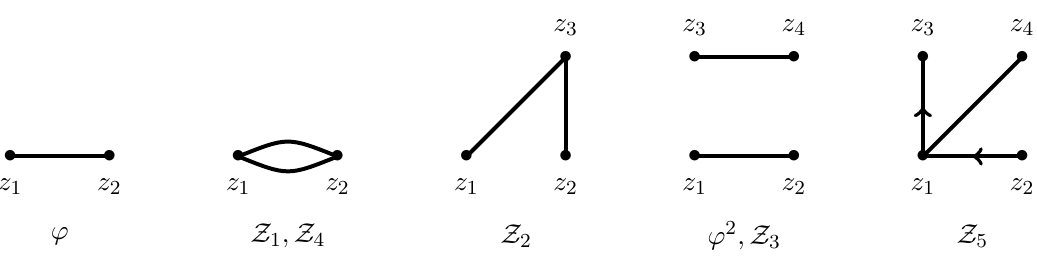
Figure 1 . Graphs representing the genus-two modular graph functions ’ , Z i and ’ 2 where each line represents the Green function G but the structure of the Abelian di(cid:11)erentials is not exhibited. The arrows on two of the lines in Z 5 indicate the derivatives @ 1 and (cid:22) @ 1 on G